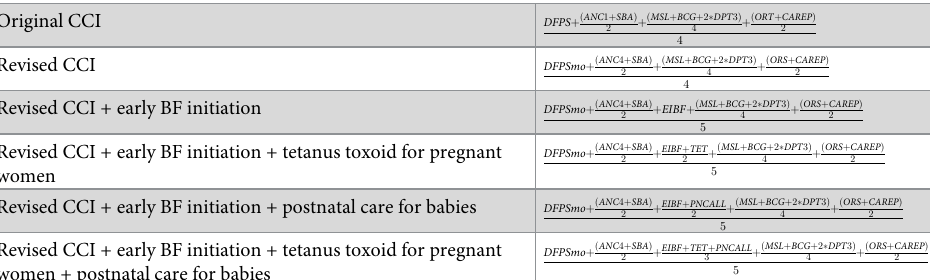
Table 1. Alternative formulations of the composite coverage index